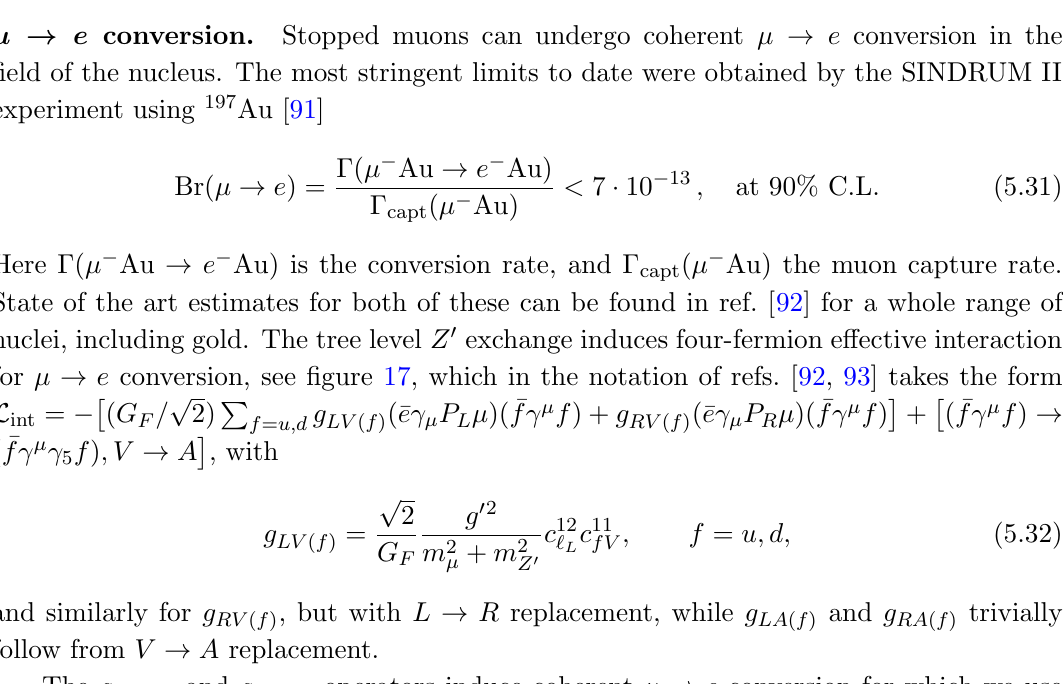
‘ j ‘ j (cid:22) ‘ j . Right : radiative decay, ‘ i !